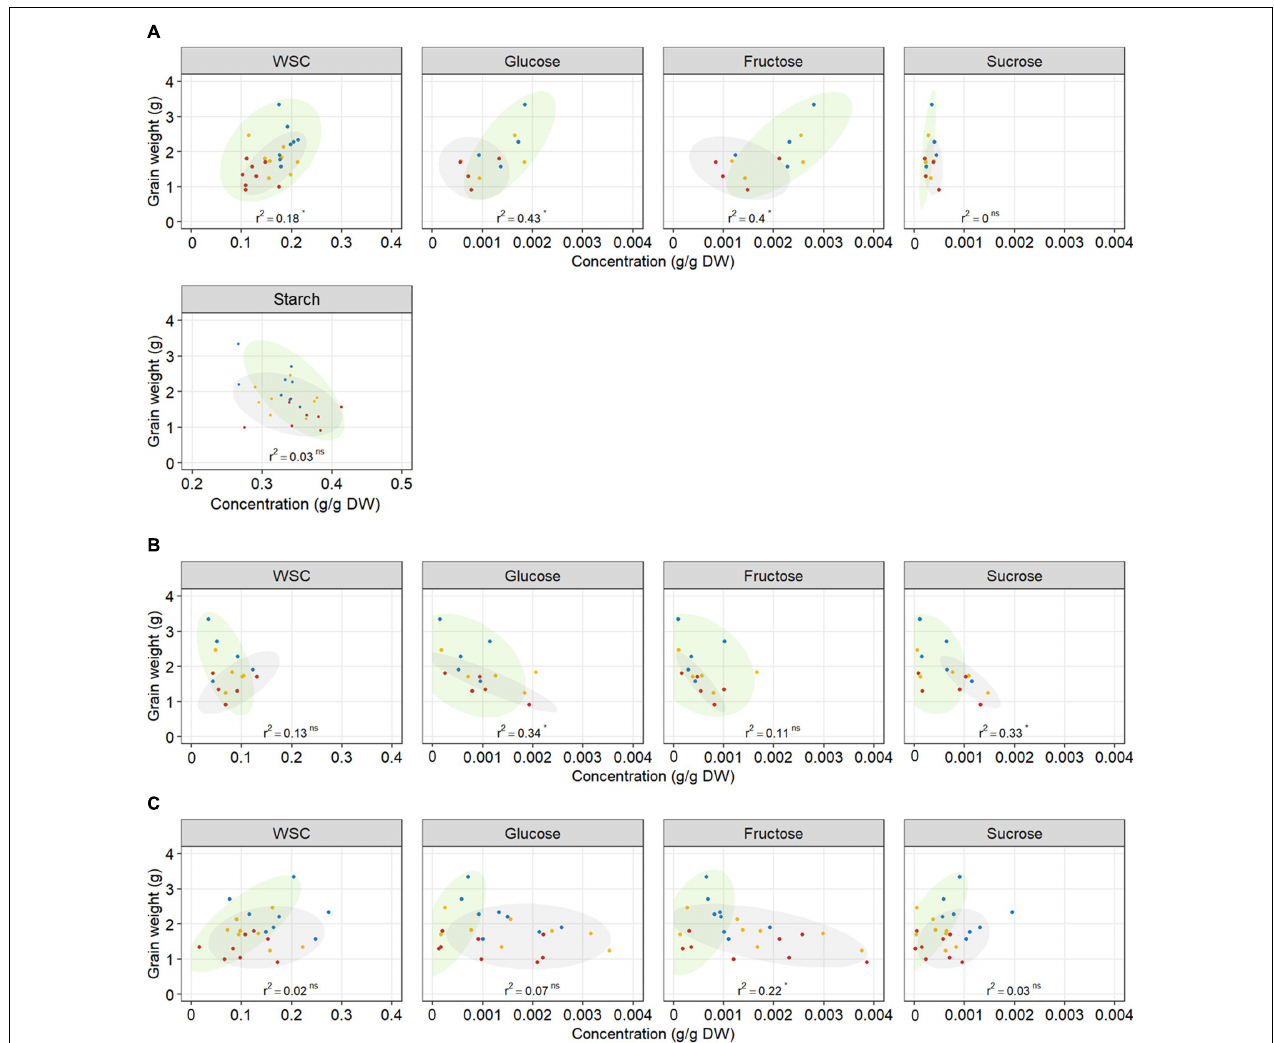
FIGURE 7 | Relationship between total WSC, glucose, fructose, sucrose, and starch concentrations in (A) grains, (B) awns, (C) the stem at 12 DAA, and final grain weight per plant. Each point represents an average of carbohydrate concentration ( n = 3) in the main tiller for one genotype and one treatment. Each regression line includes the whole dataset. r 2 and p -value of linear regressions (‘ns’ not significant, * p < 0.05) are indicated. Ellipses circle old genotypes (gray) and modern genotypes (green). Plants grown under well-watered conditions (blue), drought (orange), or combined drought and heat stress